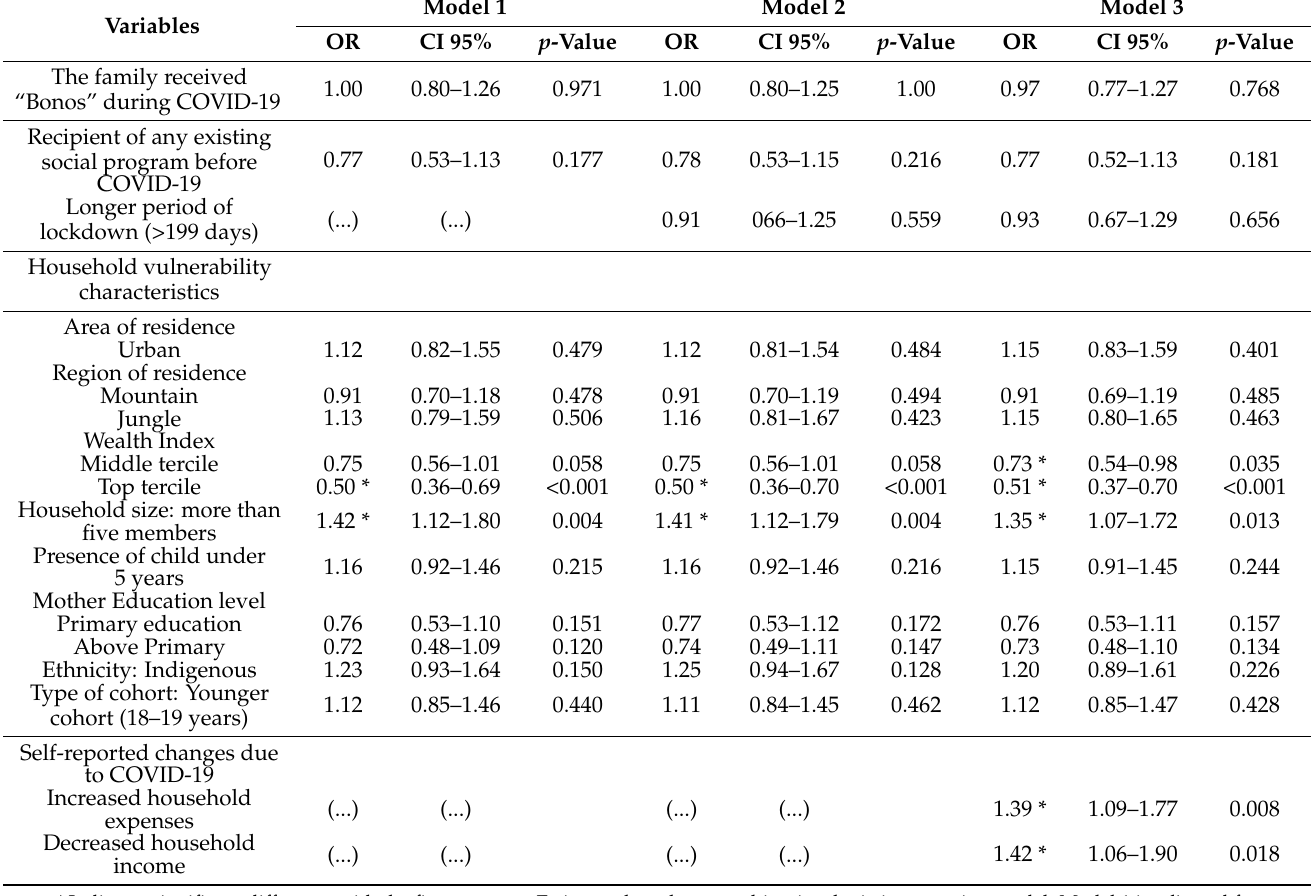
Table 3. Association of the Government support and household vulnerability characteristics with food insecurity among the YLS